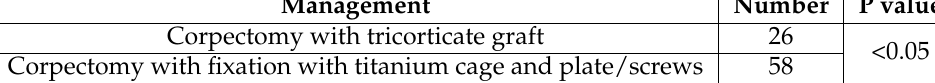
Table 5. Management performed in